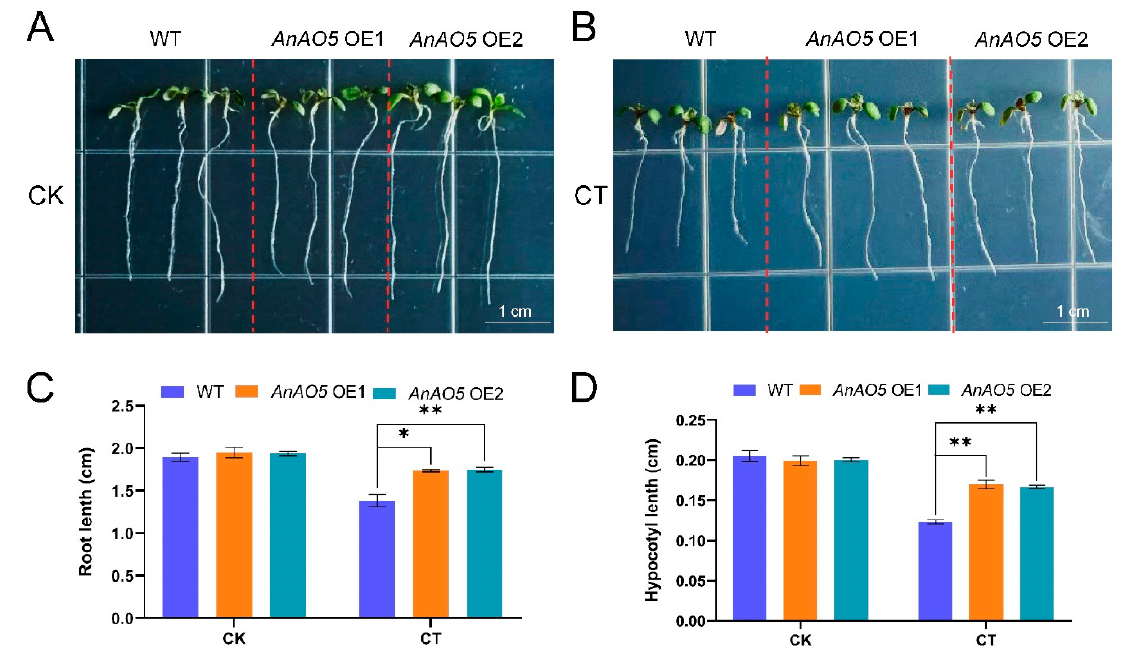
Figure 12. Overexpression of AnAO5 enhanced the tolerance of Arabidopsis seedlings to low tem- perature. ( A ) Arabidopsis seedlings of wild-type, AnAO5 OE1, and AnAO5 OE2 cultured at room temperature (22 °C). ( B ) Arabidopsis seedlings of wild-type, AnAO5 OE1, and AnAO5 OE2 cultured under cold stress (15/10 °C). ( C ) The root lengths of Arabidopsis seedlings of wild-type, AnAO5 OE1, and AnAO5 OE2 in CK and CT. ( D ) The hypocotyl lengths of Arabidopsis seedlings of wild-type, AnAO5 OE1, and AnAO5 OE2 in CK and CT. Values are expressed as means ± SD ( n = 3), and statistically significant differences were evaluated using Student’s t-test, * p < 0.05, ** p < 0.01.